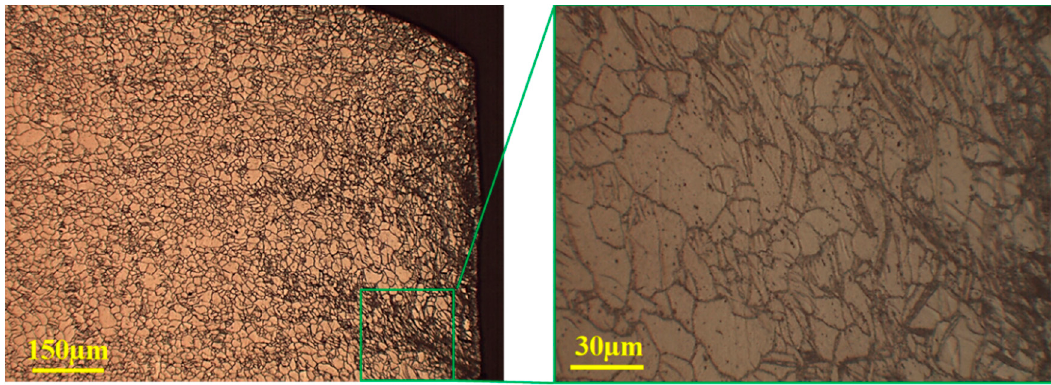
Figure 20. Optical microstructure of the shear zone at 150 °C and 20% clearance.